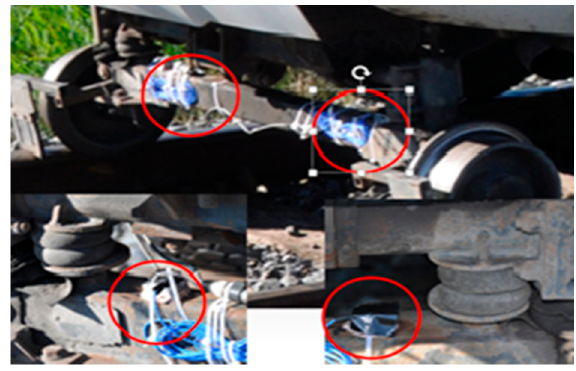
Figure 2. Test vehicle and accelerometers.